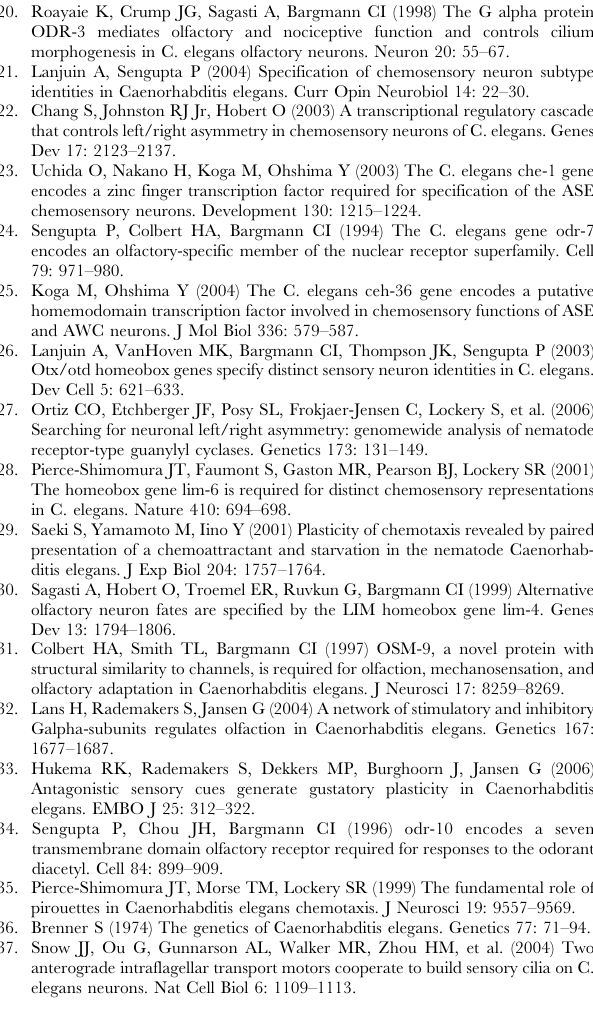
Figure S2 Effects of salts in plate on NH 4 Ac chemotaxis.